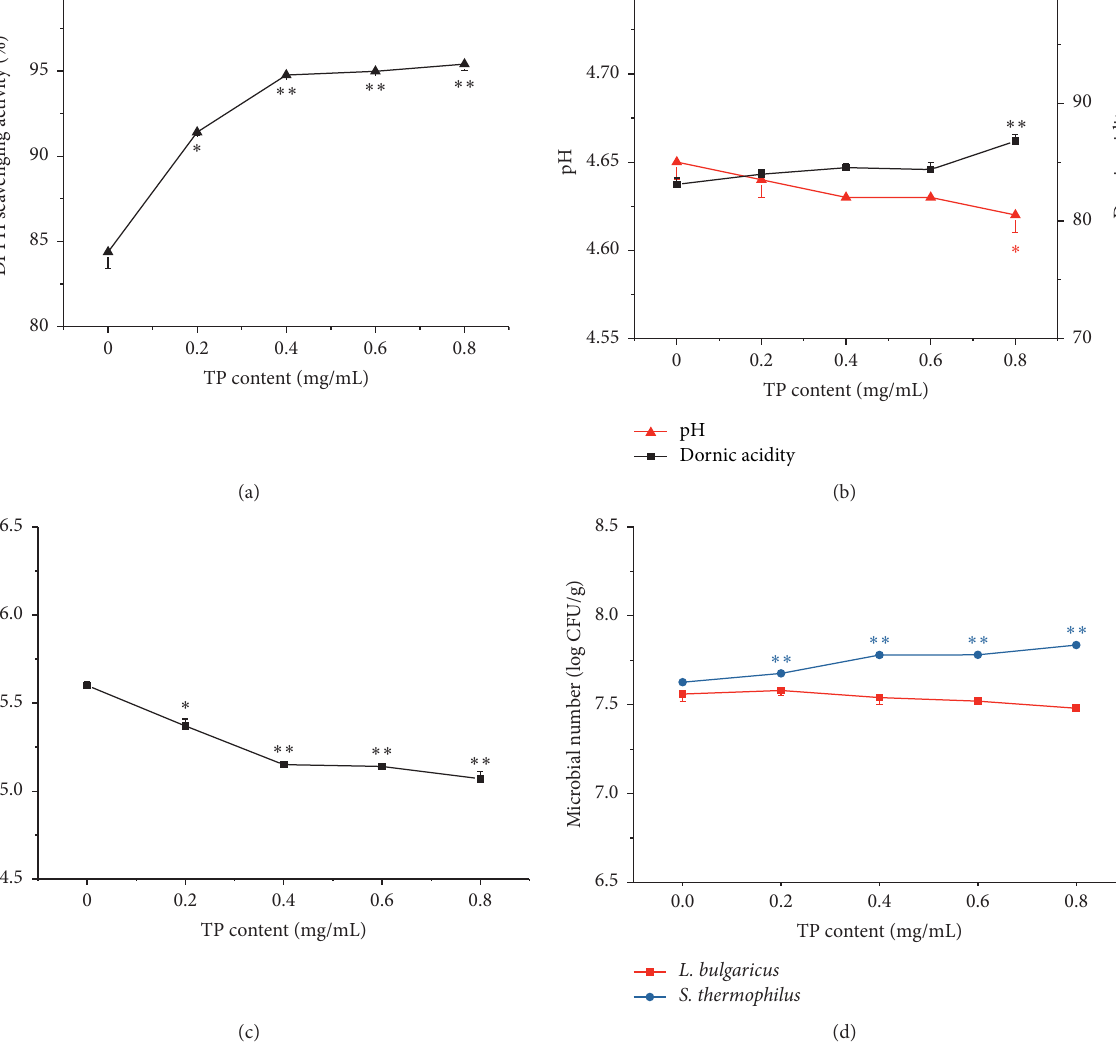
Figure 4: Co-supplementing different contents of TP with 2.4% FSE influenced on the antioxidant activity, physicochemical profiles, and microbial counts of yogurts: (a) DPPH scavenging capacity; (b) pH and Dornic acidity; (c) fermentation time; (d) quantities of L. bulgaricus and S. thermophilus. ∗ Significant difference at p < 0 . 05; ∗∗ significant difference at p < 0 . 01 compared with FSE2.4. FSE: Flos Sophorae extract; TP: Tremella fuciformis polysaccharides; FSE2.4: the yogurt with 2.4%